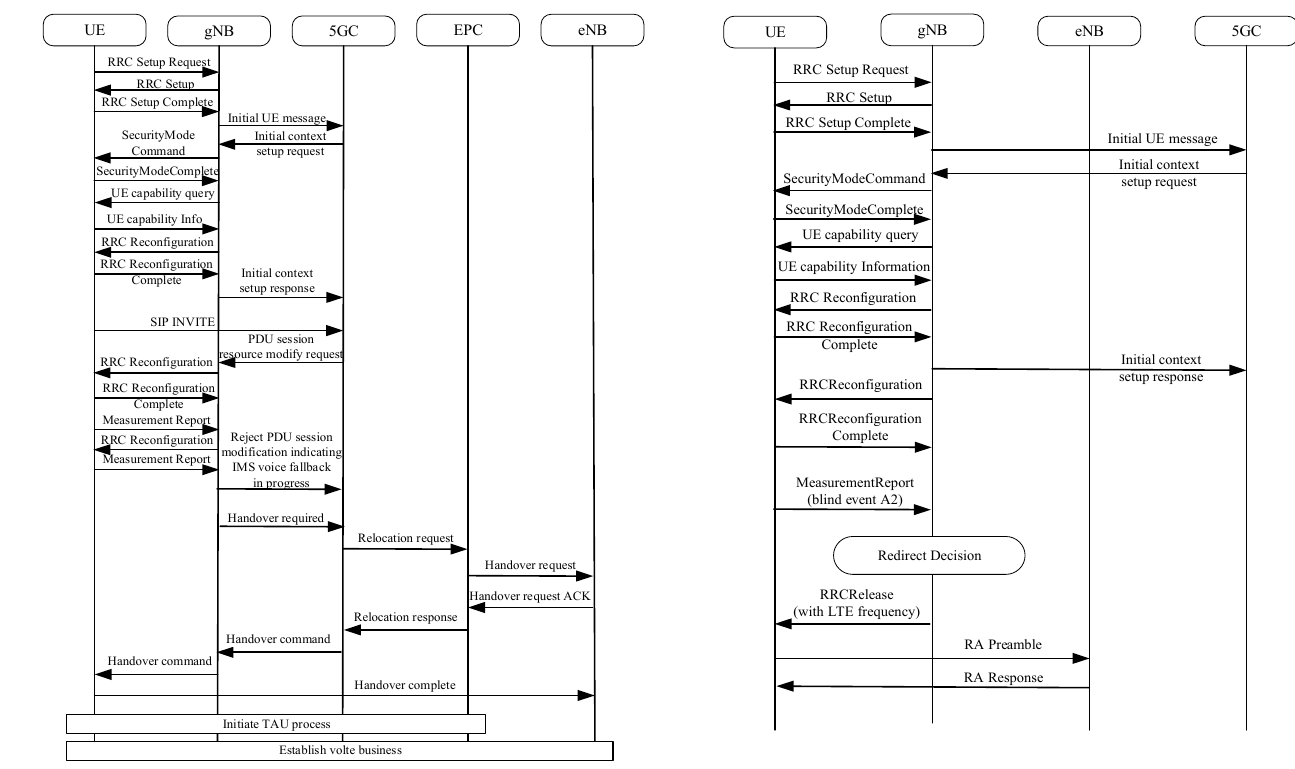
Figure 6. EPS Fallback flow based on handover/redirection.